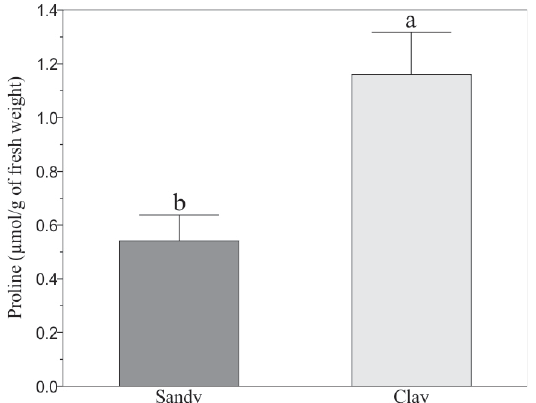
Figure 4. Proline accumulation in chili pepper leaves grown in sandy and clay soils. Comparison of means and S.E. by using Tukey ′ s test. In all cases, p = 0.05. In the case of gene expression analysis, there was a non-significant difference.